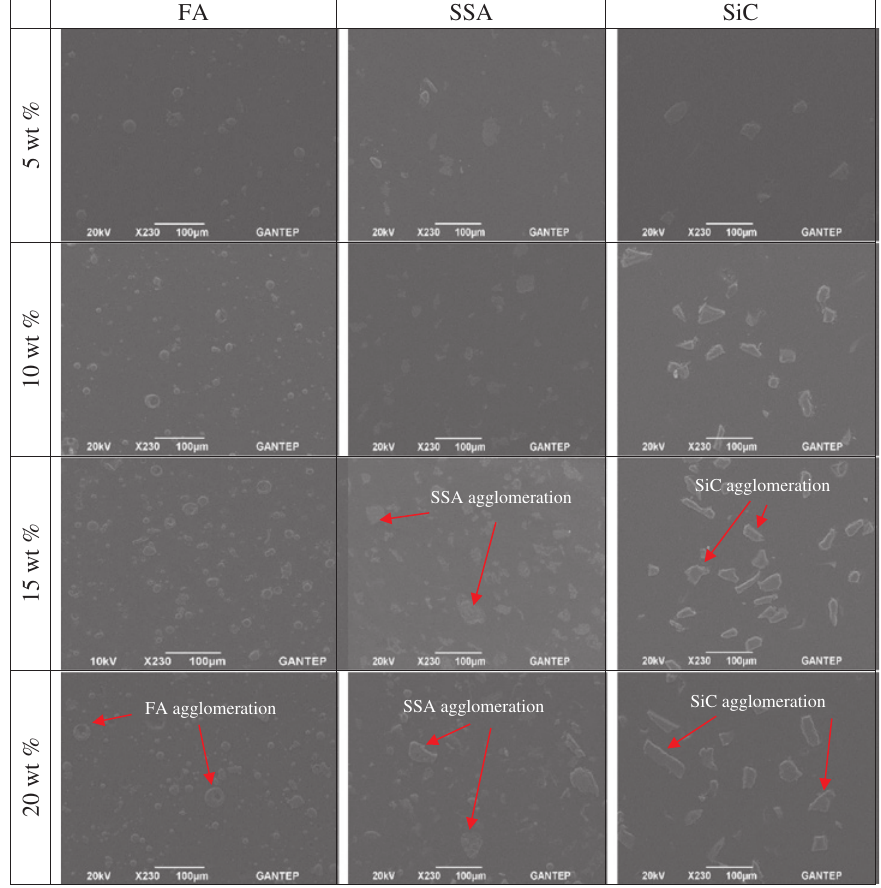
Table 2: SEM micrographs of composite samples at various content of filler (images are at a magnification of 230 × ). FA SSA SiC